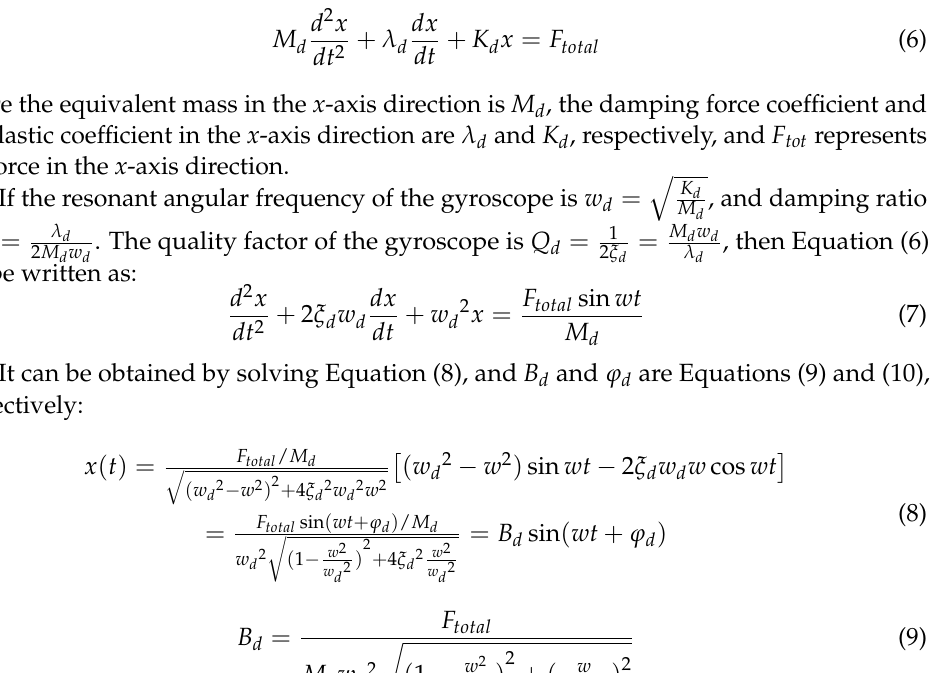
Figure 2. Schematic diagram of mechanically sensitive structure of MEMS gyroscope. When the AC frequency of the voltage applied to the driving electrode is the same as the natural frequency of the mass in the x -axis direction, the central proof mass of the gyro starts to generate harmonic motion. The dynamic equation of displacement in the driving direction can be written by Equation (6).